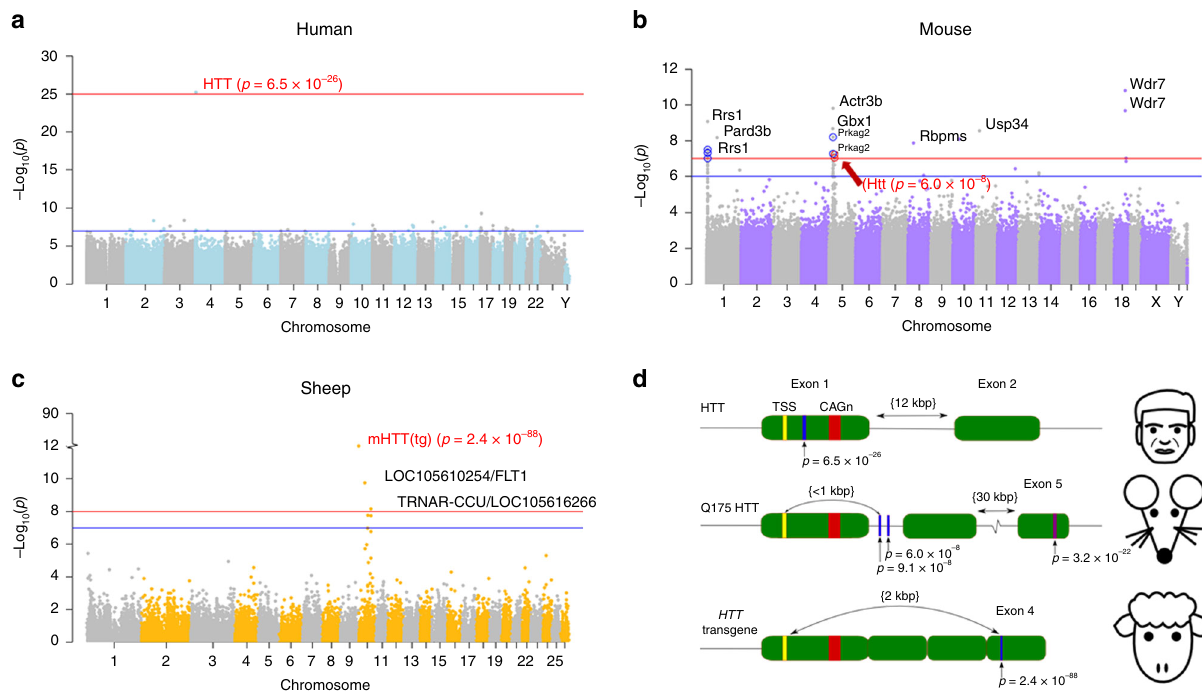
Fig. 4 Epigenome-wide association study (EWAS) of HD status in three species. HDGEC status (carrier versus control) was related to DNA methylation data in three different species: a human blood, b mouse striatum/cerebellum, and c sheep blood. Each Manhattan plot reports minus log 10 -transformed p values ( y -axis) versus chromosomal location. Each dot corresponds to a CpG. CpGs near HTT are marked in red. Human HTT is located in chromosome 4. Mouse Q175 knock-in in Htt is located on mouse chromosome 5. Sheep transgenic gene HTT is located on sheep chromosome 10. The blue horizontal lines correspond to genome-wide signi fi cance levels for a , c ( α = 1.0 × 10 − 7 ) and a suggestive signi fi cance level for b (1.0 × 10 − 6 ); the red horizontal lines correspond to p < 1.0 × 10 − 32 , p < 1.0 × 10 − 7 , and p < 1.0 × 10 − 8 for a – c , respectively; the break in the y -axis indicates where the level of signi fi cance has been truncated for the purpose of visualization. b CpGs marked in blue on chromosome 1 are located in Ryrs1 . CpGs marked in red and blue on chromosome 5 are located in Htt and Prkag2 , respectively. d The alignment of signi fi cant CpGs (blue vertical lines) in the human (hg38), mouse (mm10) and sheep (oviAri4) HTT locus. The signi fi cant HTT / Htt CpGs ( p < 1.0 × 10 − 7 ) are colored in blue with p values displayed below for human, mouse (RRBS methylation array), and sheep EWAS, respectively. The most signi fi cant CpG found using the mouse methylation array data are colored in